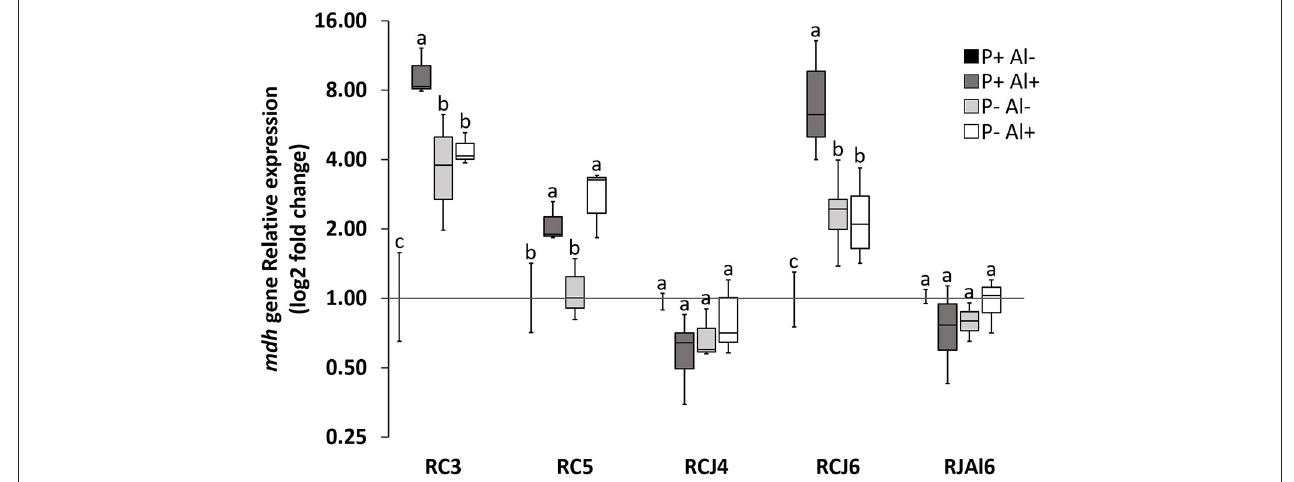
FIGURE 2 | Relative quantification of malate dehydrogenase ( mdh ) gene of five phosphobacteria: Klebsiella sp. RC3, Stenotrophomonas sp. RC5, Klebsiella sp. RCJ4, Serratia sp. RCJ6, and Enterobacter sp. RJAL6 grown in a modified mineral culture medium (MCM) with contrasting P and Al concentrations. P + : 1.4mM KH 2 PO 4 ; P–: 0.05mM KH 2 PO 4 ; Al + : 10mM AlCl 3 × 6H 2 O; Al–: without Al added. Different letters on bars denote significant differences ( P ≤ 0.05; Tukey’s test) in phosphatase activity among treatments and